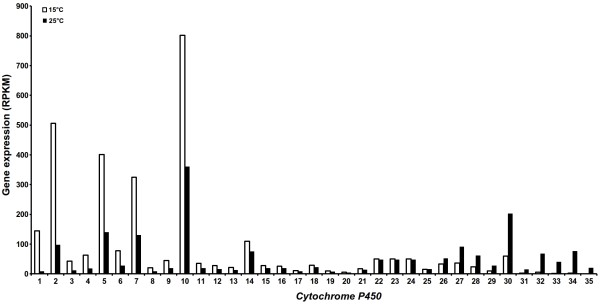
Reads per exon kilobase per million (RPKM) values based gene expression of annotated cytochrome P450s (CYPs) in P. kurrooa transcriptome. A total of 33 unigenes were annotated as putative CYPs in P. kurrooa transcriptome. Their expression was studied at 15°C and 25°C based on RPKM values. Numerals 1-33 represent 33 CYPs in the dataset, where 4, 6, 8, 9, 12-16, 18, 21, 23-24, 27-28, 30 were classified as putative CYPs. Details of other numerals are as follows 1, flavonoid 3'-hydroxylase; 2, CYP92A46; 3, flavonoid 3'-hydroxylase; 5, cytochrome P450 NADPH-reductase; 7, CYP72A57; 10, CYP72A11; 11, CYP721A1; 17, coniferaldehyde 5-hydroxylase; 19, ABA 8'-hydroxylase CYP707A1; 20, CYP707A1; 22, cytochrome P450 monooxygenase CYP83G2; 25, cytochrome P450 monooxygenase CYP72A59; 26, cytochrome P450 monooxygenase CYP83E8; 29, cytochrome P450 CYP85A1; 31, CYP83B1; 32, CYP71AT2v2; and 33, cytochrome P450 fatty acid omega-hydroxylase. Details on accession number and BLAST are mentioned in Additional file 14.